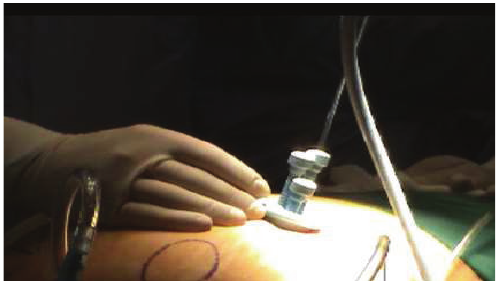
Figure 1: Creation of pneumoperitoneum. Figure 2: Mutliple port access.